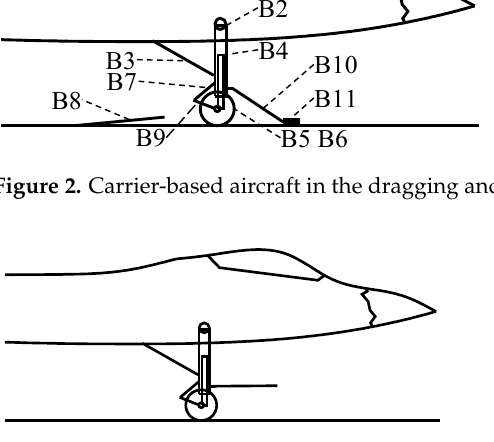
Figure 3. Carrier-based aircraft in the free-rolling phase.